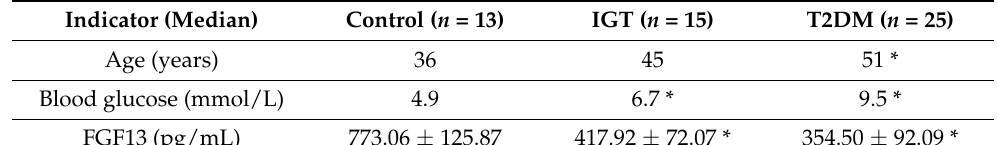
Table 1. Comparison of data of patients in three groups (* p < 0.05 vs. control).